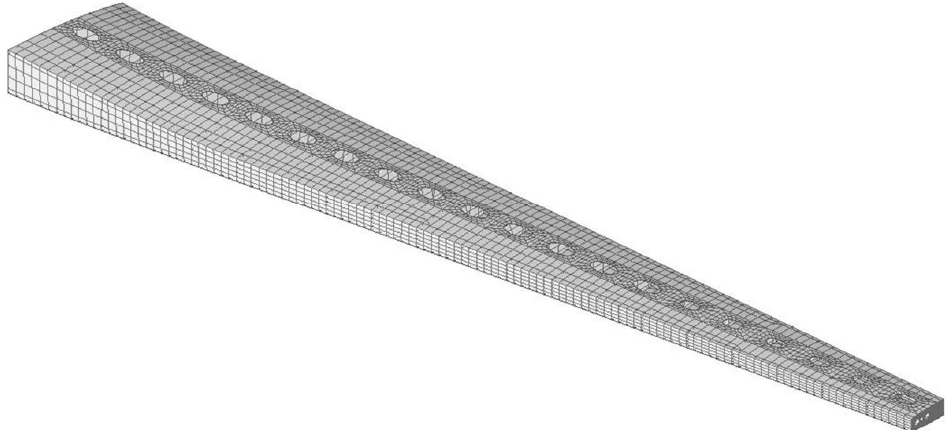
Figure 4. Test Problem 1: finite element mesh of the wing box (bottom